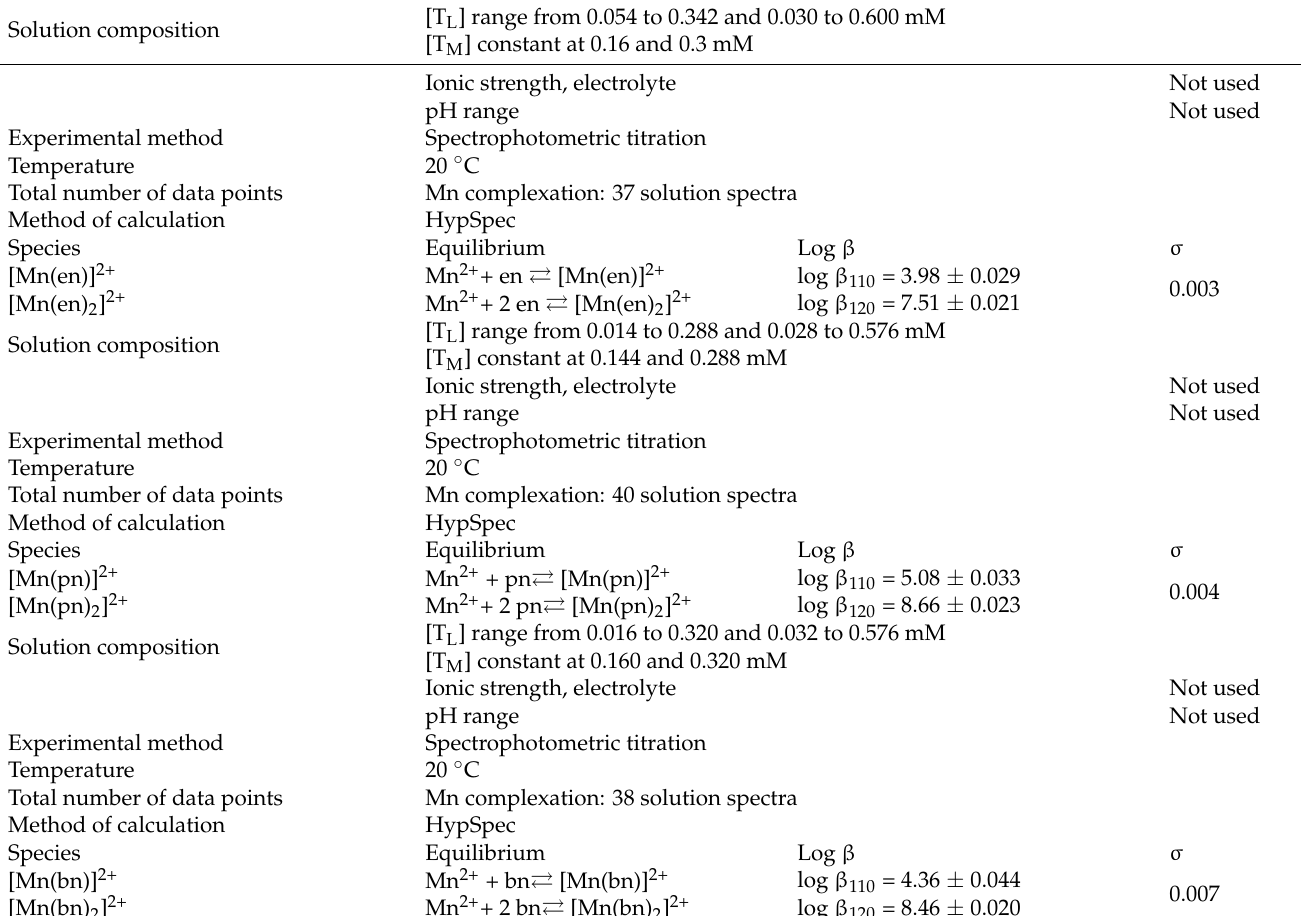
Table 1. Summary of experimental parameters for systems with manganese(II) and ethylenediamine, 1,3-propanediamine or 1,4-butanediamine, in